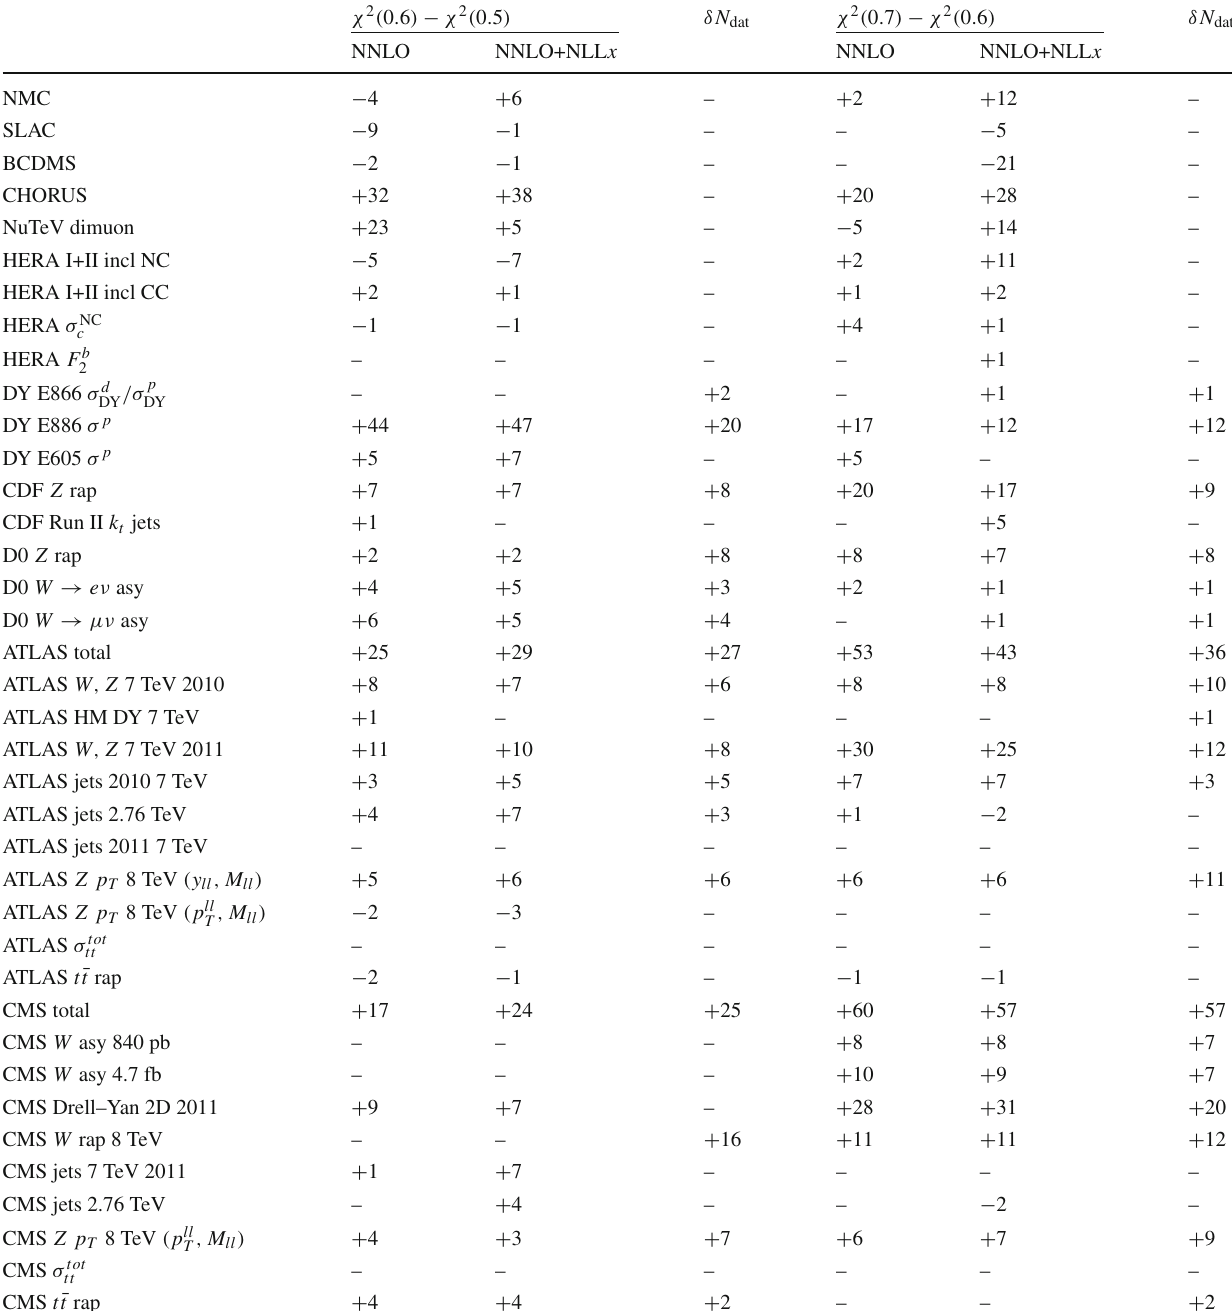
Table 6 The differences δχ 2 ≡ χ 2 for the global fits reported in Table 5. Since the fits with different values of H cut have in general a different number of data points for